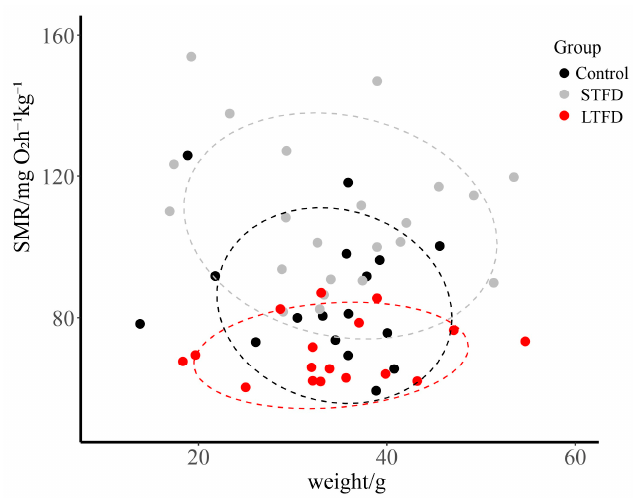
Figure 6. Relationship between the standard metabolic rate and weight of the black rockfish ( Sebastes schlegelii Hilgendorf, 1880). Legend: black dots represent the control group, gray dots represent the STFD group, and red dots represent the LTFD group.